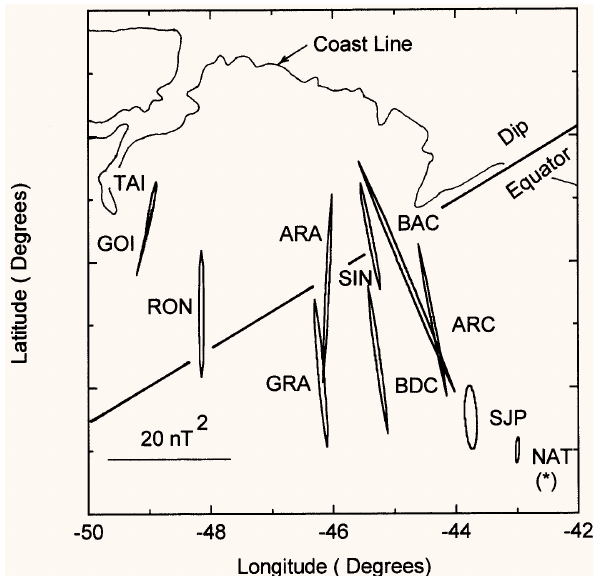
Fig. 4. Polarization ellipses for the Pc5 event of 24 March 1991 (1100–1400 UT). Length of major axis represents magnitude of po- larized spectral power. Location of NAT is arbitrarily marked.